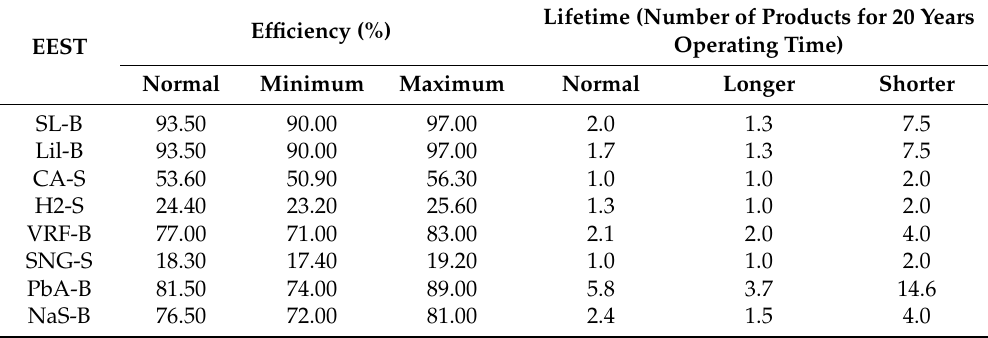
Table 3. Data for variation of efficiency and lifetime in the sensitivity analysis